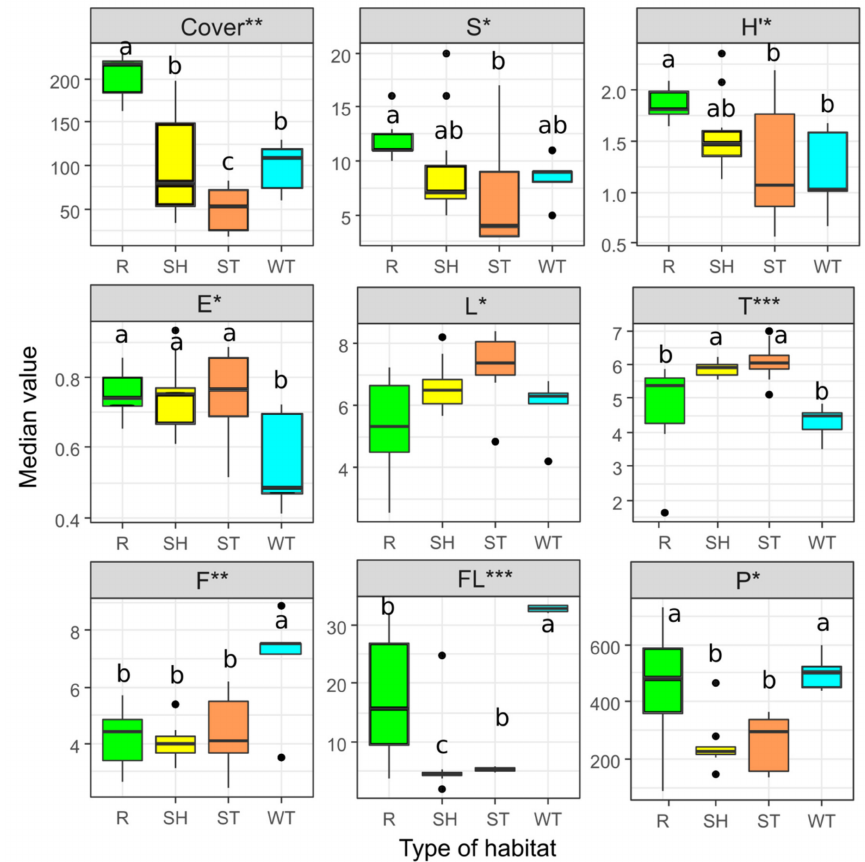
Figure 3. Comparison of the total cover of plants (COVER), species richness (S), Shannon-Wiener index (H’) and evenness index (E); Ellenberg indicators for light (L), temperature (T), and moisture (F); soil characteristics for phosphorus (P), and floatable parts (FL), among study sites. R—reference site, adjacent forest, SH—sand heaps, ST—sandy bottom of sedimentation tank, WT—wetlands. Significance of the differences according to the Fisher-Pitman test *— p < 0.05; **— p < 0.01, ***— p < 0.001. The same lowercase letters indicate no significant